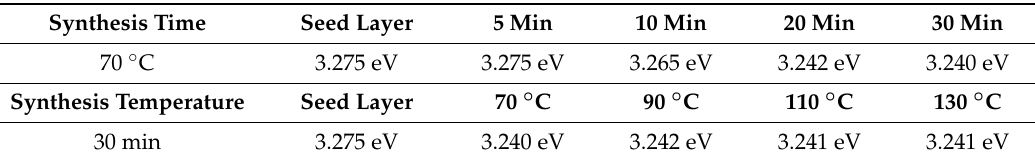
Table 1. Optical band gap of ZnO nanorods, produced with different synthesis time and temperature, obtained by extrapolating ( α h ν ) 2 vs h ν .